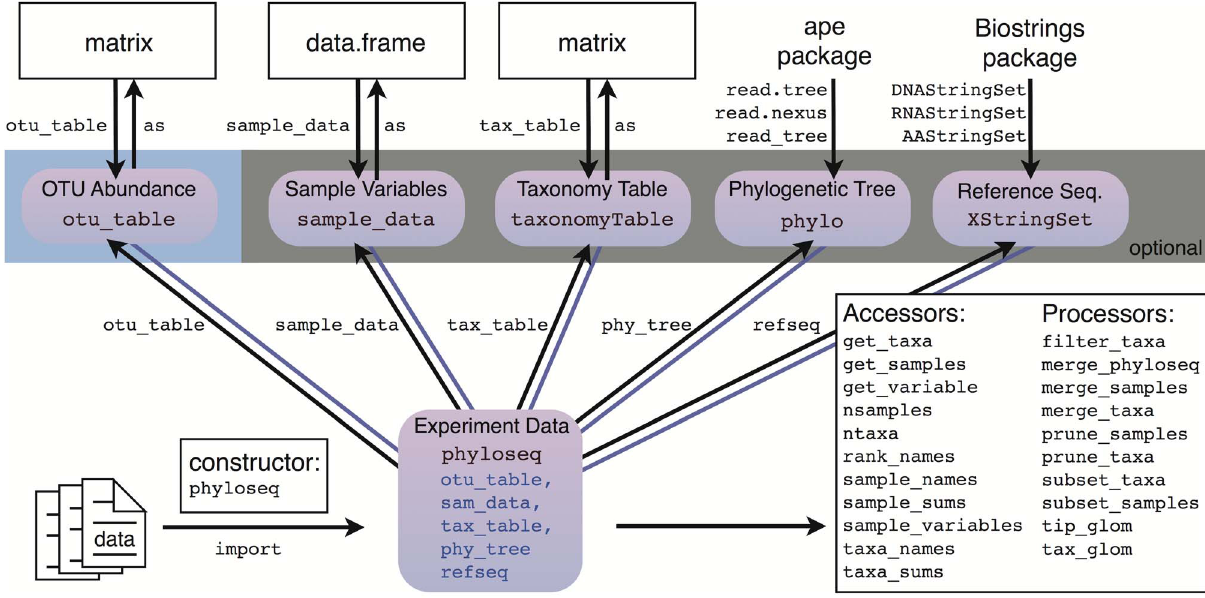
Figure 3. The ‘‘phyloseq’’ class. The phyloseq class is an experiment-level data storage class defined by the phyloseq package for representing phylogenetic sequencing data. Most functions in the phyloseq package expect an instance of this class as their primary argument. See the phyloseq manual [38] for a complete list of functions.